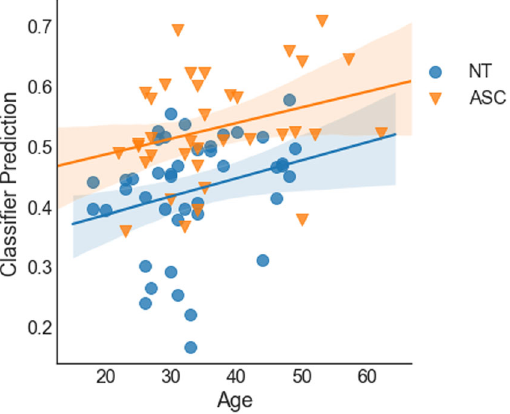
Fig. 3 Class probability for ASD and participant ’ s age.